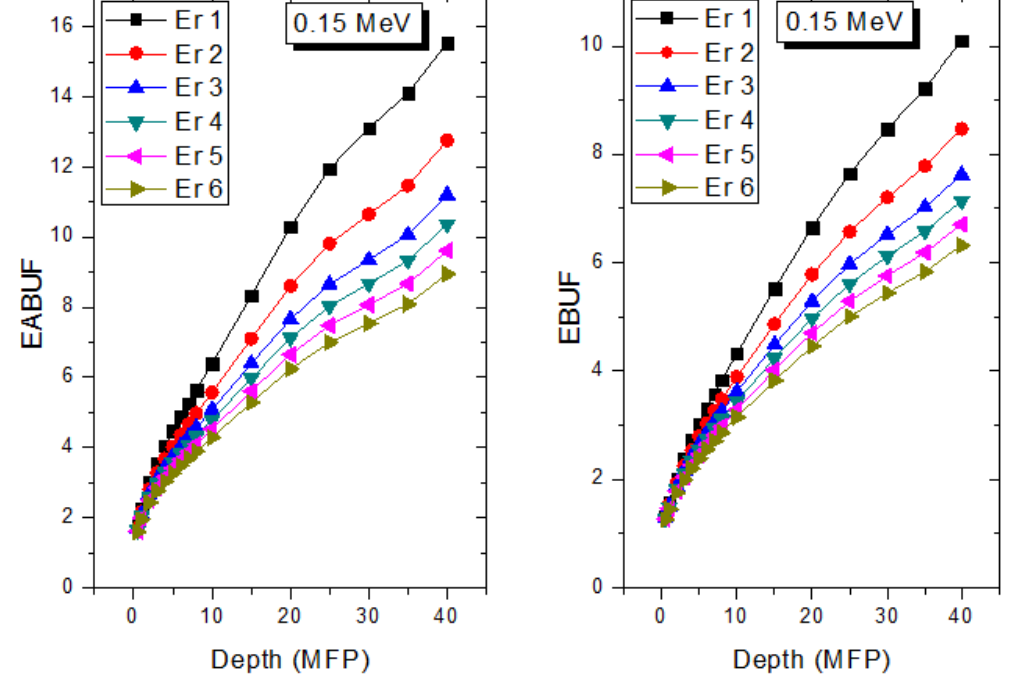
Figure 8. Effect of chemical composition on EABUF and EBUF at different depth for 0.15 MeV photon energy.